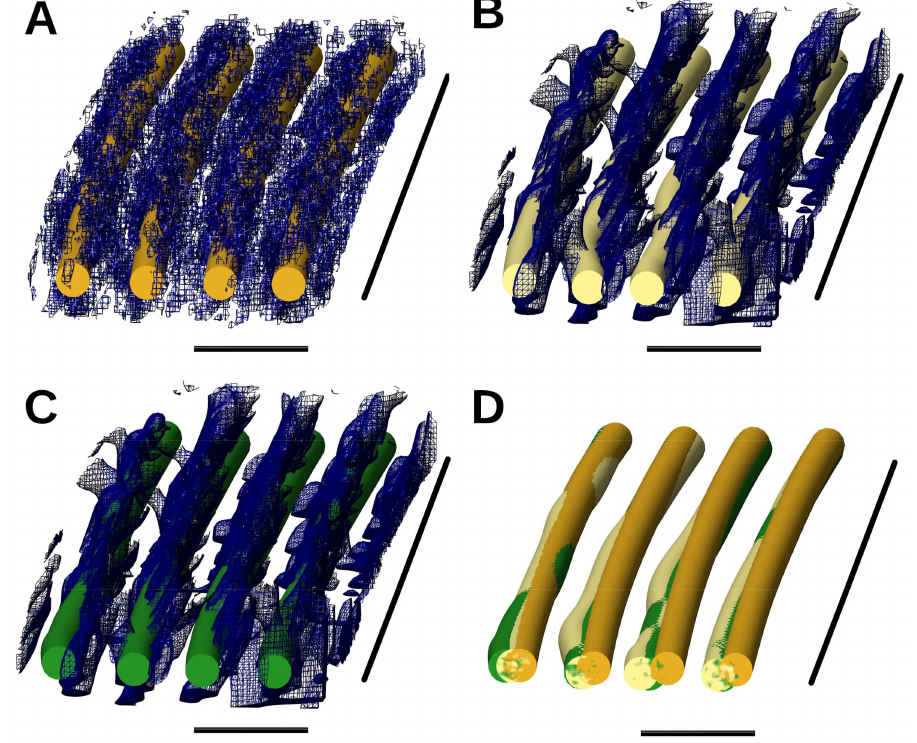
Figure 6. A local view of filaments that were built after applying a polynomial regression for denoising. ( A ) Filaments built manually (gold) overlaid with the original map; ( B ) filaments built using one-peak convolution (khaki) overlaid with the denoised density map created using a polynomial regression; ( C ) filaments built using the seven-peak convolution (green) overlaid with the denoised density map created using a polynomial regression; ( D ) superposition of the three sets of filaments in ( A – C ). For ( A – D ), the horizontal scale bar is 20 nm, and the vertical scale bar is 630